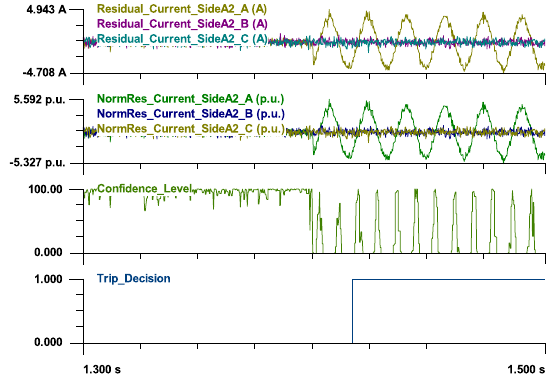
Fig. 20 EBP relay performance of event 5: internal high impedance fault, grid-connected mode, 1% random error